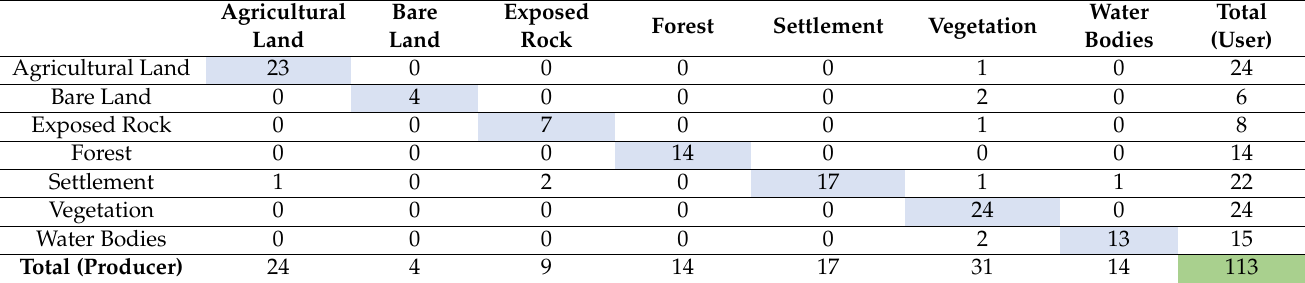
Table A6. Accuracy assessment table of 2009 LU/LC